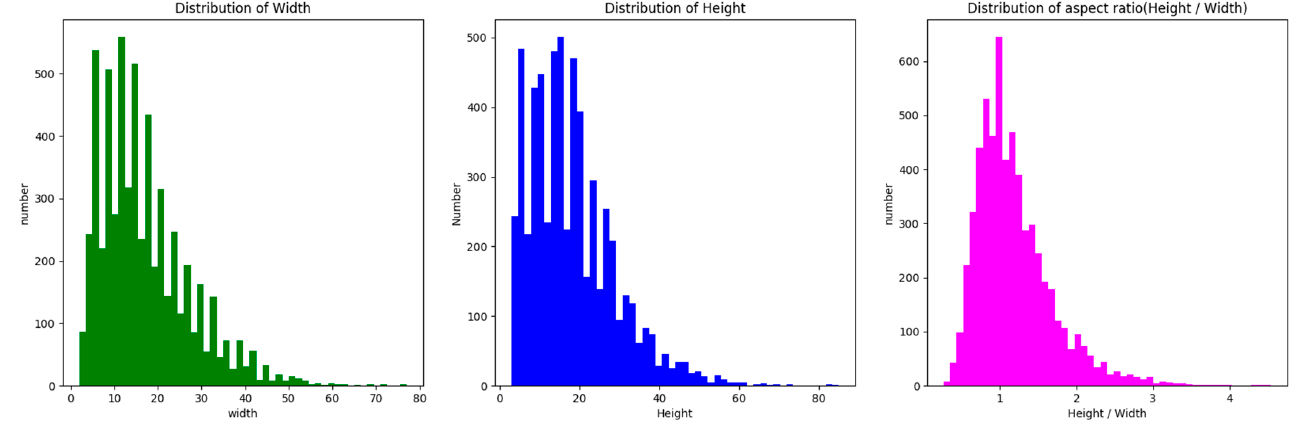
Figure 7. A sample image of LS-SSDD-v1.0.